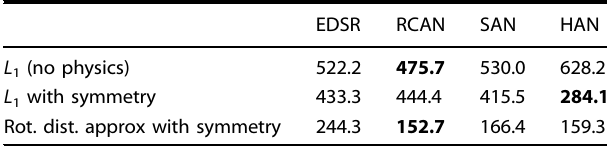
Table 4. Percent feature difference over input: rows represent different loss functions and columns represent different network